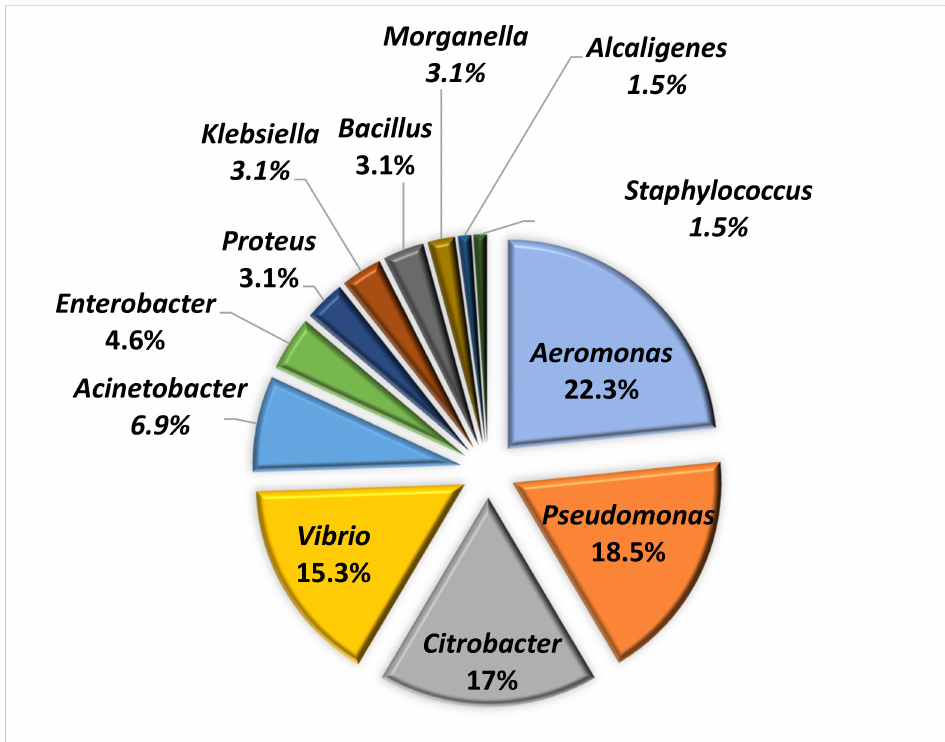
Figure 3. Distribution of genera found in clinical